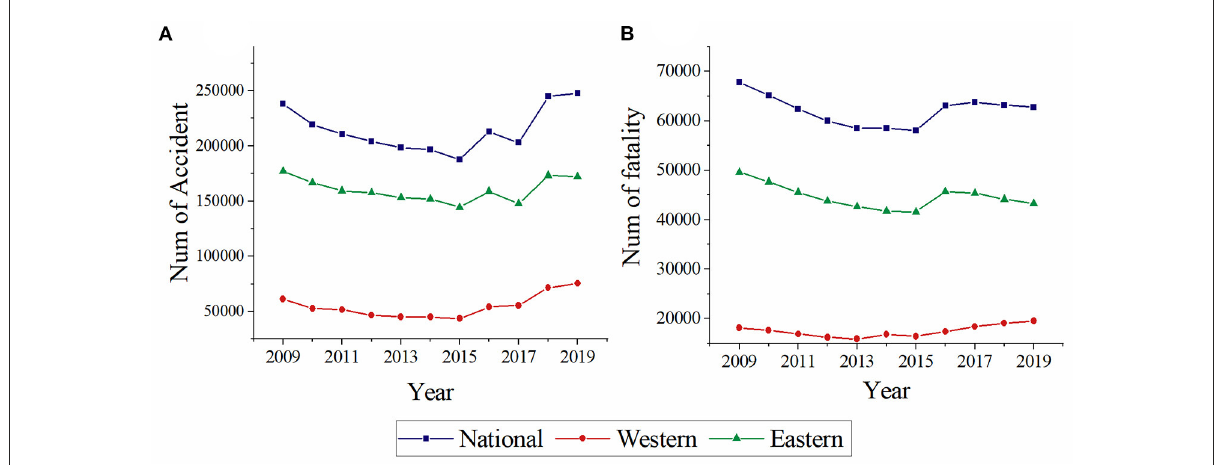
FIGURE1 Annual distribution of traffic accidents (A) and fatalities (B) at western, eastern, and